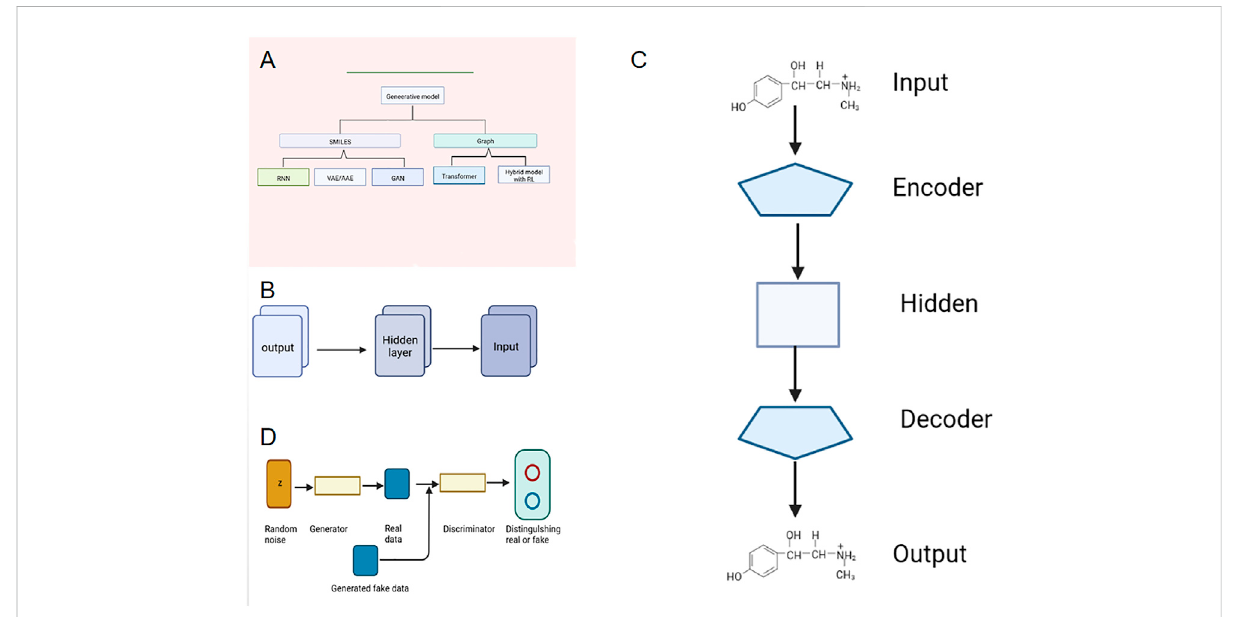
FIGURE 1 Different mode indication. (A) Generative Models for Molecular Design. (B) Structure of RNN. (C) Structure of VAE. (D) Structure of